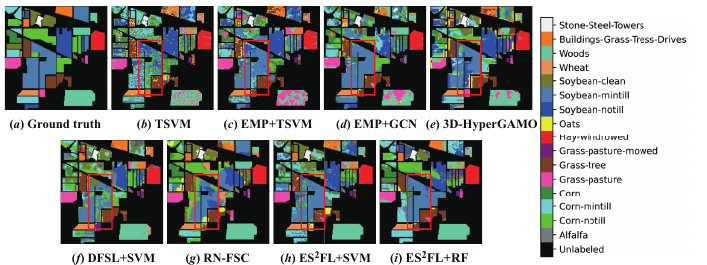
Figure 8. The classification maps resulting from different methods on the IP data set in the case of small samples.